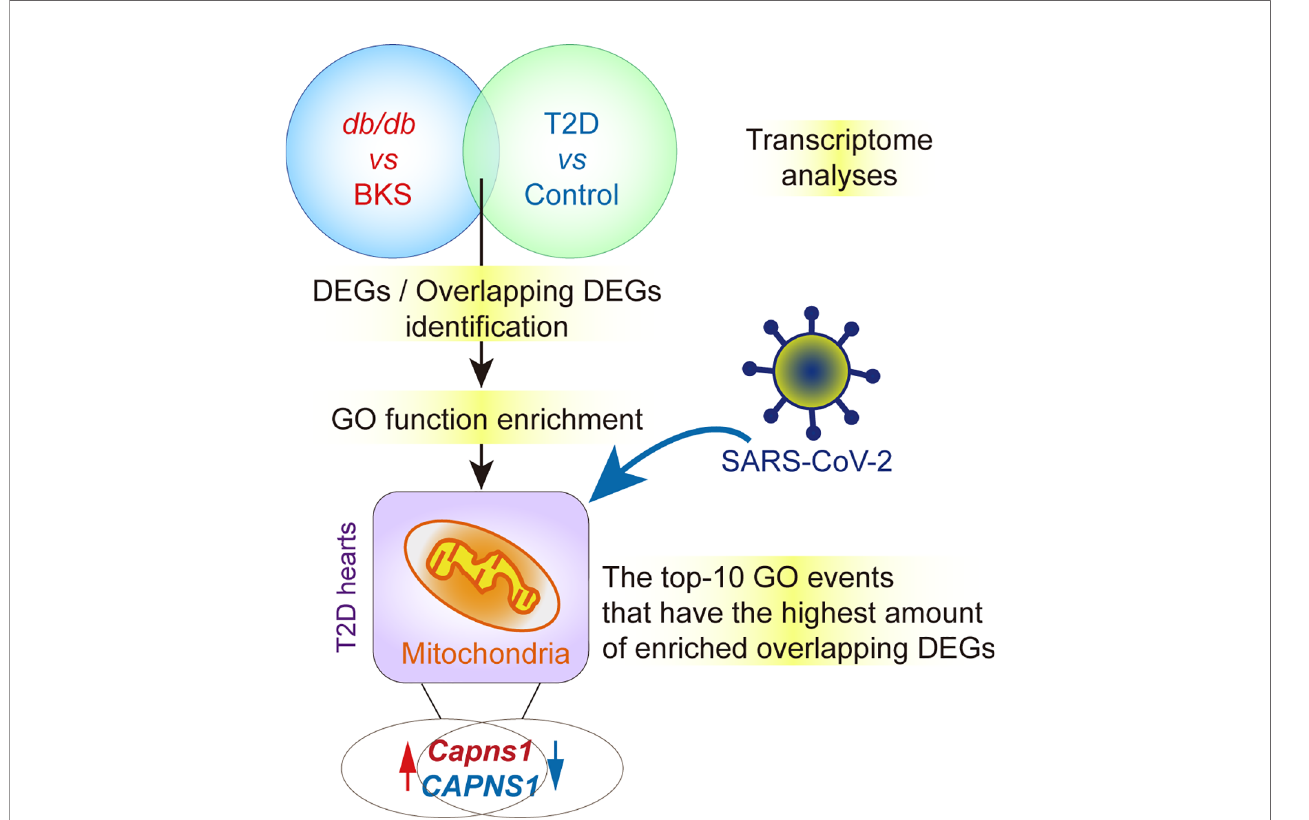
FIGURE 6 | ∣ Hypothesis contributing to crucial gene and key functions in T2D hearts with and without SARS-CoV-2 infection. Capns1 / CAPNS1 is the unique gene shared by molecular function module and cellular components module of overlapped DEGs, and involved in catalyzing JP2 hydrolysis, T2D hearts should possess intrinsic CAPNS1-dependent self-protective mechanism. The autopsy heart specimens of T2D patients display attenuated transcription of CAPNS1 in the case of SARS-CoV-2 infection. Attenuated cardiac CAPNS1 transcription in T2D patients who succumbed to SARS-CoV-2 infection must decrease in the ability to hydrolyze JP2 and weaken self-protective mechanism, thereby leading to adverse